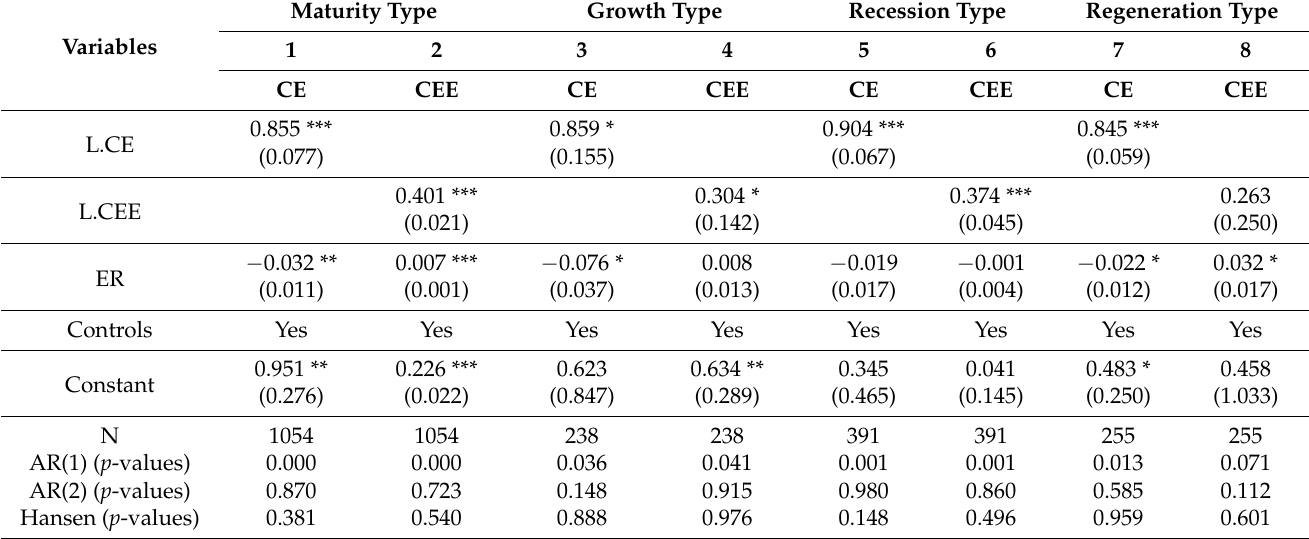
Table 9. Regression results at different types of